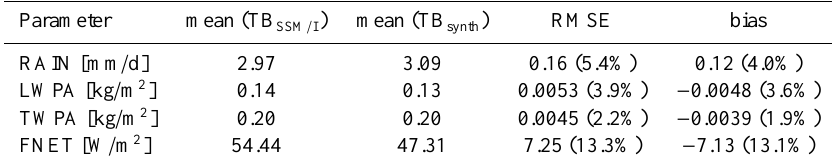
Table 3. Global mean error values for parameters calculated with synthesized brightness